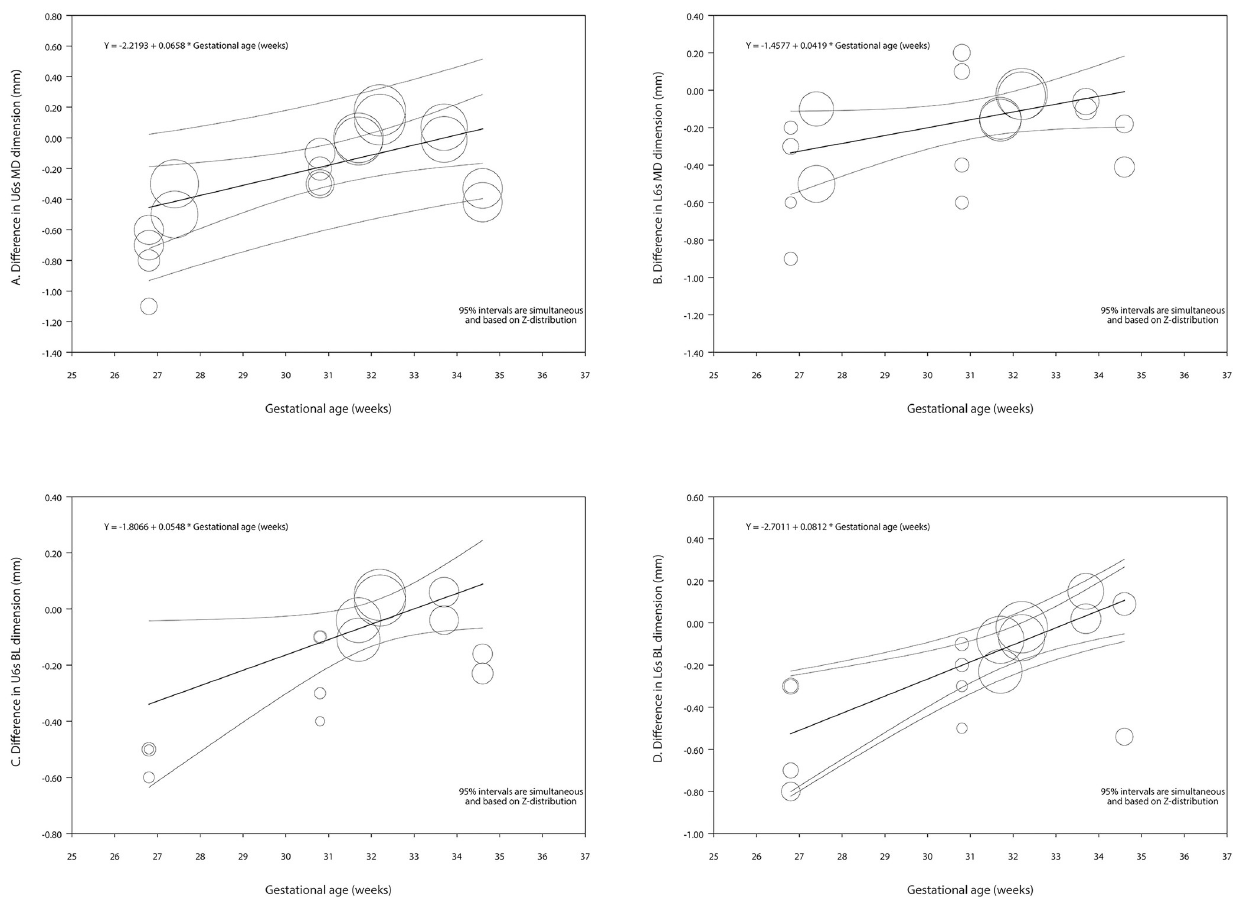
Fig 6. Regression scatterplots of the difference in teeth dimension between preterm and control children, on the predictor of gestational age (in weeks). A. Maxillary first molar—Mesiodistal dimension. B. Mandibular first molar—Mesiodistal dimension. C. Maxillary first molar—Buccolingual dimension. D. Mandibular first molar—Buccolingual dimension. Confidence intervals and prediction intervals are displayed (inner and outer lines around the regression line). BL: Buccolingual; MD: Mesiodistal; L: Lower dental arch; U: Upper dental arch.